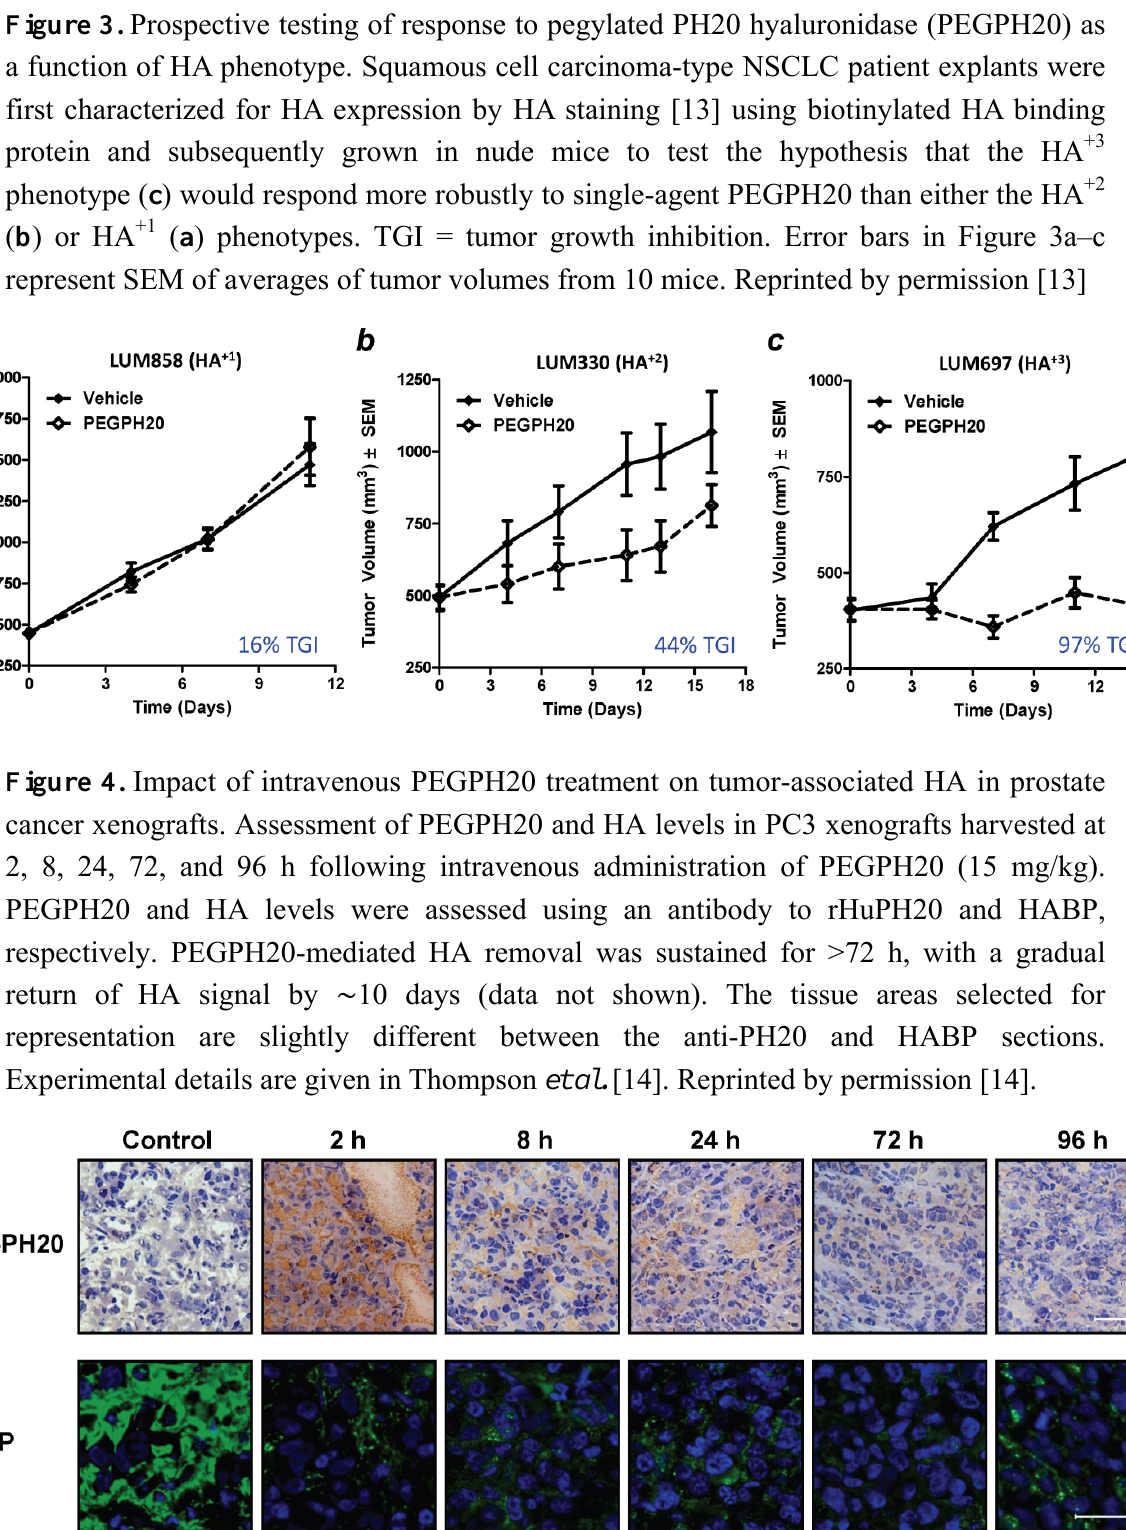
Figure 3. Prospective testing of response to pegylated PH20 hyaluronidase (PEGPH20) as a function of HA phenotype. Squamous cell carcinoma-type NSCLC patient explants were